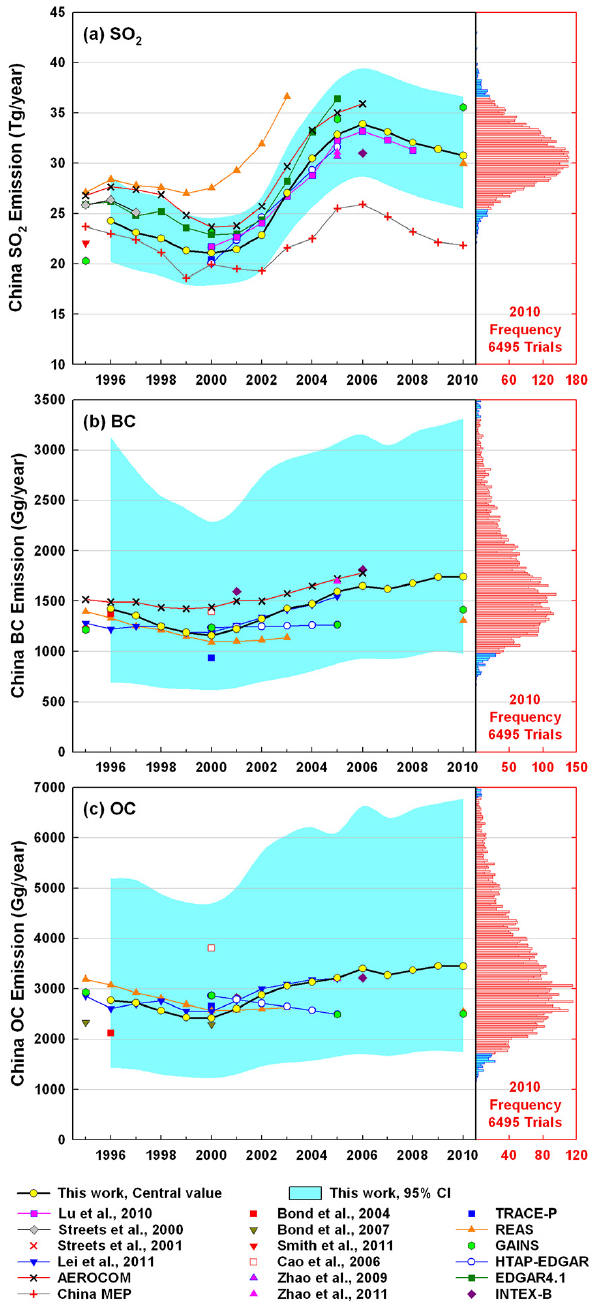
Fig. 6. Comparison of emission estimates (excluding emissions from open biomass burning) for India: (a) SO 2 , (b) BC, and (c) OC. The right subgraphs present the distributions of estimated emissions in 2010. The blue bars are beyond the 95%